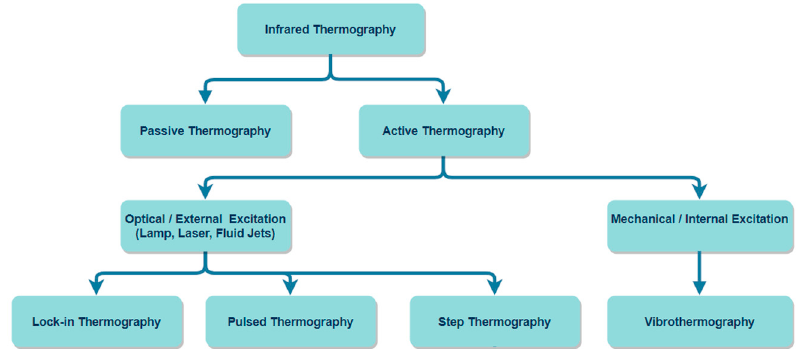
Figure 1. Classification of common infrared thermography techniques used in NDT.